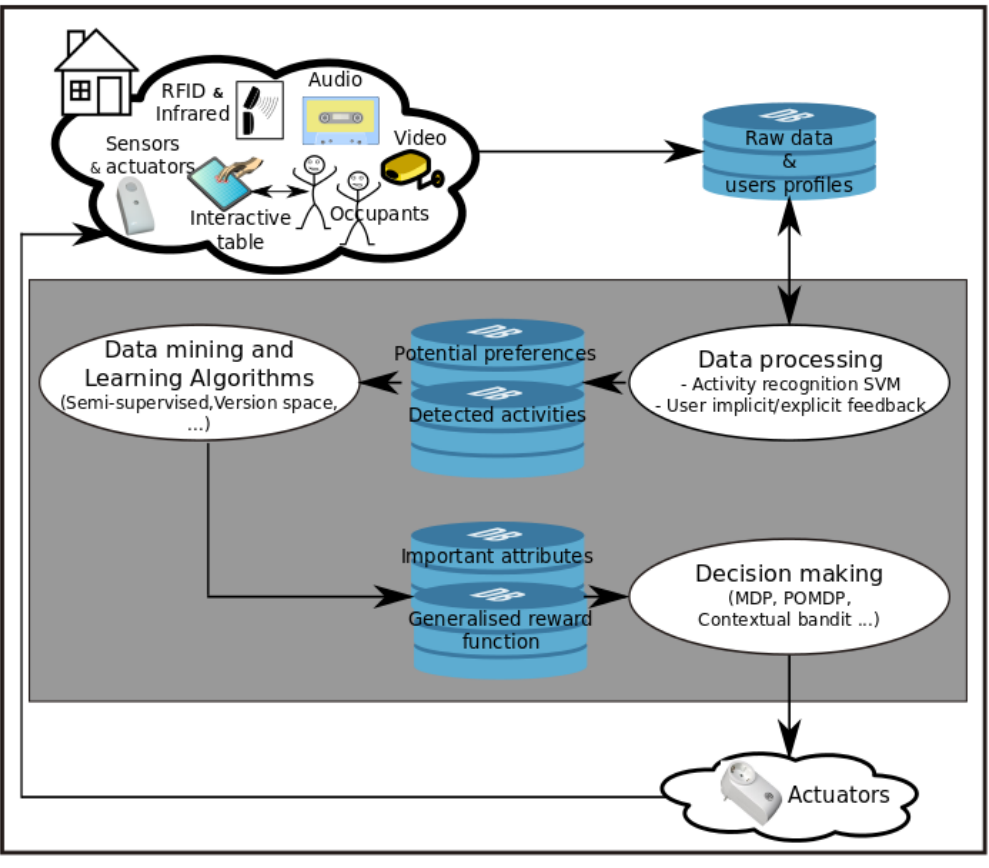
Figure 1. Description of the global architecture of the system, from raw value acquisition to decision